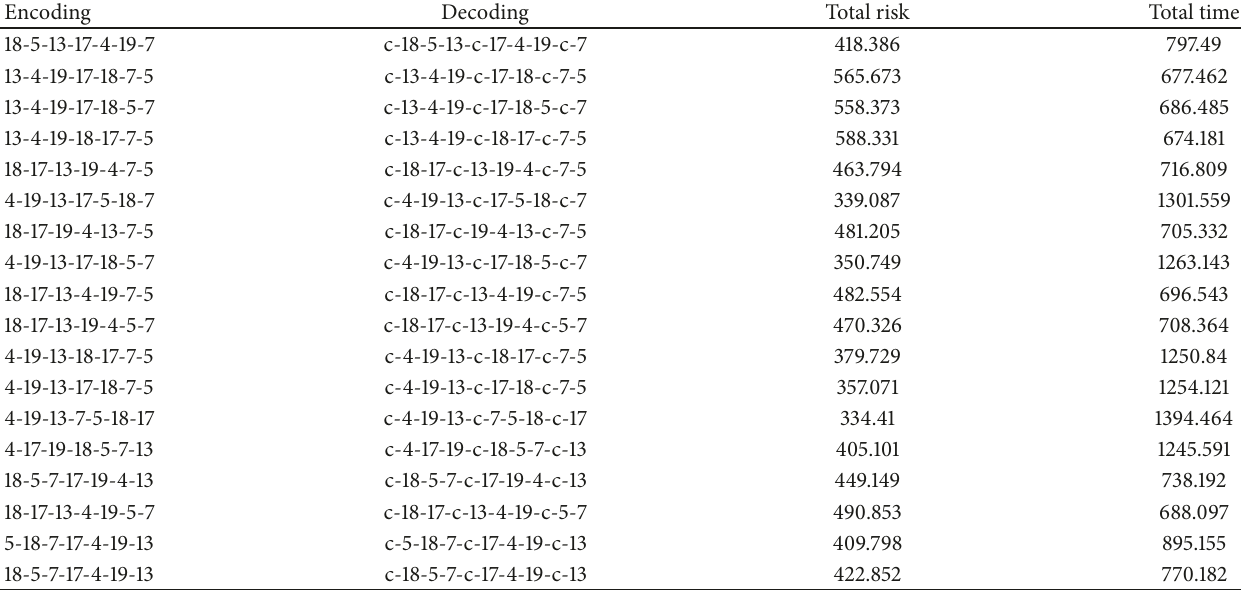
Table 13: Pareto solution set of robust control parameters Γ =20 for distribution center c.